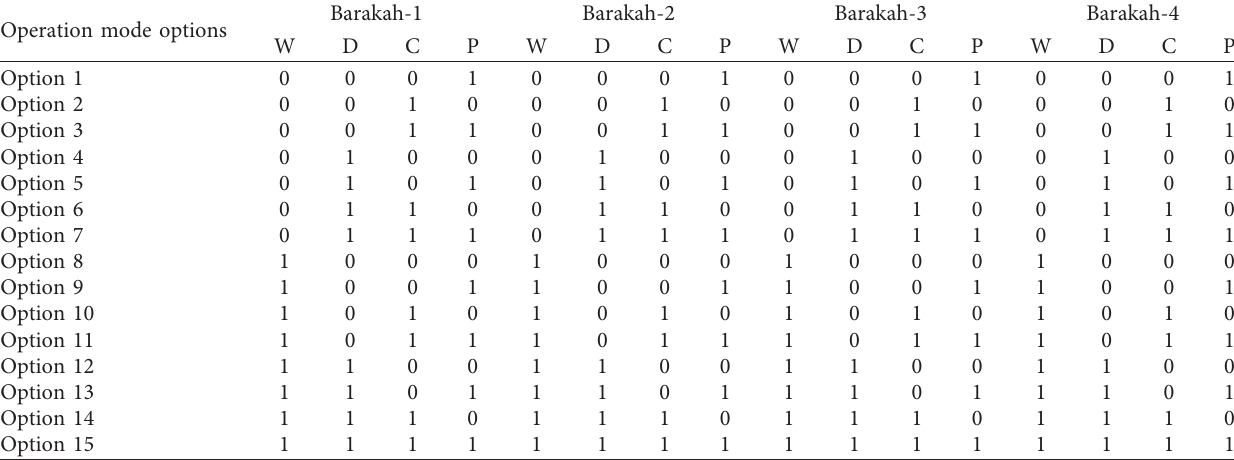
Table 12: (ON � 1 and OFF � 0) switching operation mode for (W, D, C, and P) facility options in Barakah site. Operation mode options